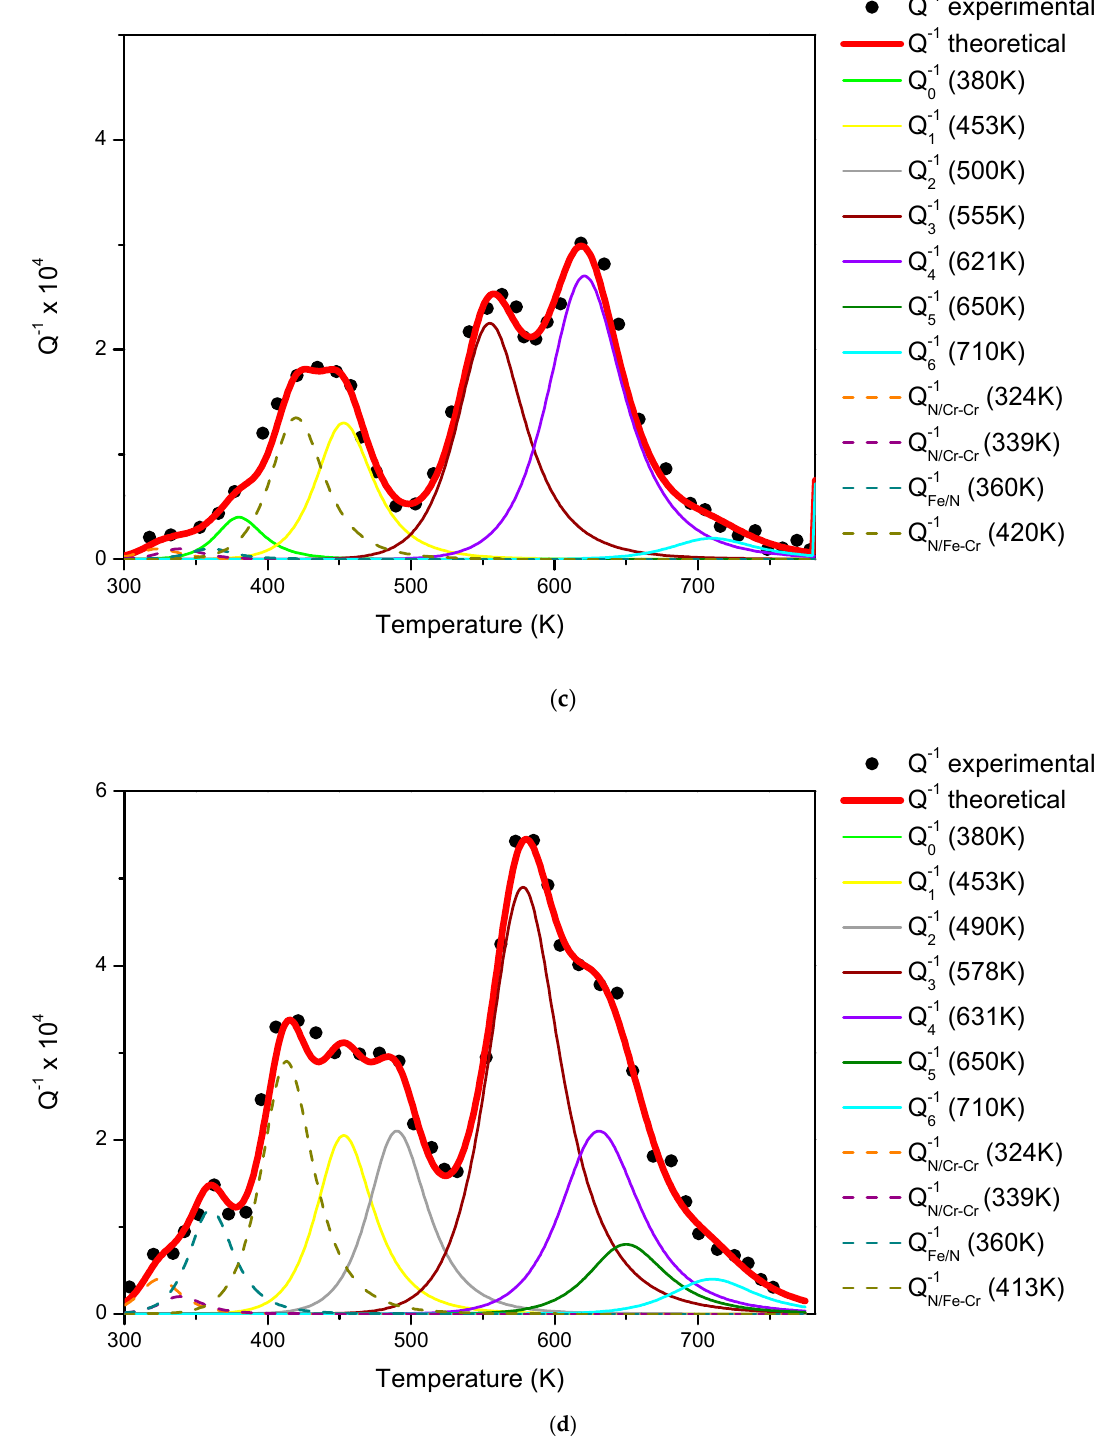
Figure 7. Q − 1 curves of samples quenched at 3600 ( a , b ) and 150 K/min ( c , d ), and treated at 973 K for 3.6 × 10 4 s ( a , c ) and 7.2 × 10 4 s ( b , d ). Experimental data are reported after background subtraction.